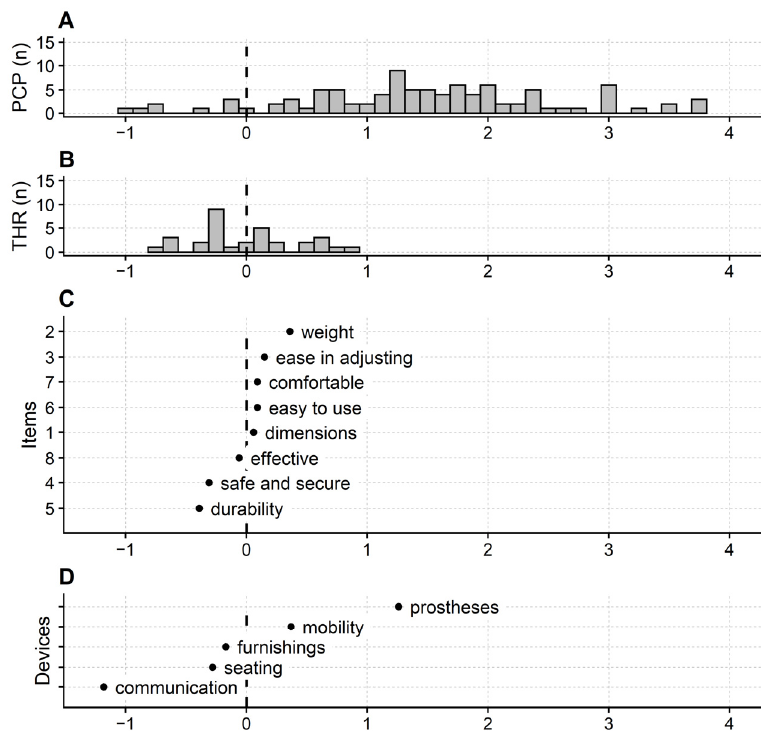
Figure 1. Questionnaire map of the QUEST 2.0–device. ( A ): distribution frequency of the patients’ measures. ( B ): distribution frequency of the items’ thresholds calibrations (Andrich thresholds). ( C ): items’ calibrations. ( D ): devices’ calibrations. Participants, items (with the Andrich thresholds), and devices are the first, second, and third facets of the Many-Facet Rating Scale model used for the Rasch analysis. PCP: participants; THR: thresholds; n : number of. Items’ content is abbreviated with a keyword, and the ordinate gives the item number in the questionnaire. Devices are abbreviated as in Table 1. Items and devices are ordered low to high, from the easiest to the most difficult to endorse. Extreme participants are not shown.